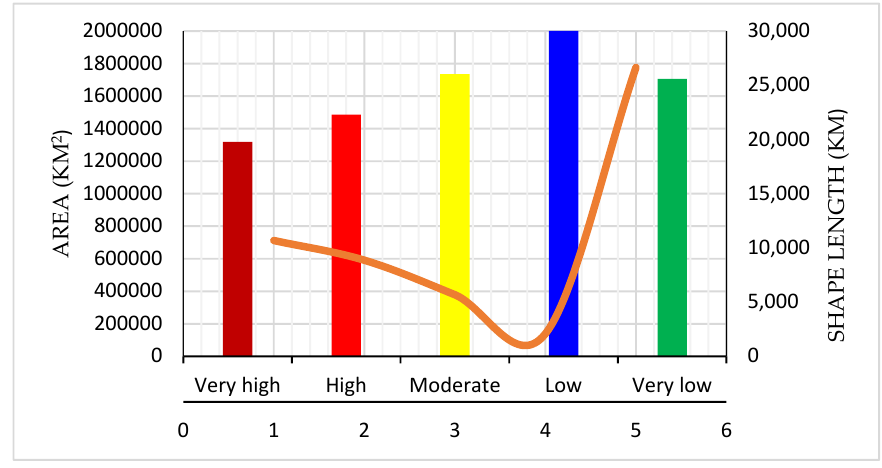
Figure 10. Graphical presentation of probability among classes, area, and distance.